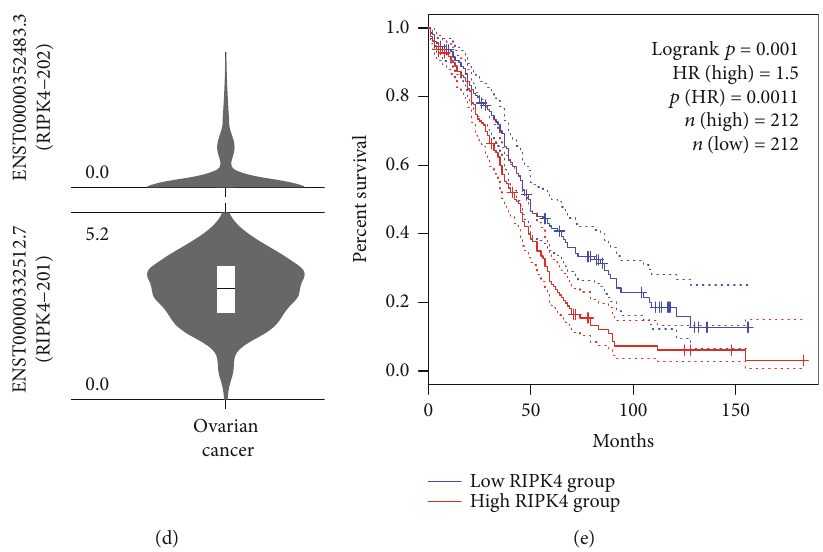
Figure 1: The expression and prognostic information of RIPK4 in OC, as analysed by GEPIA. (a) Large-scale expression pro fi ling of RIPK4 in di ff erent types of carcinoma. (b) RIPK4 mRNA expression in OC patients ( N = 426 ) was signi fi cantly higher than that in normal people ( N = 426 ) ( ∗ P < 0 : 05 ). The red column contains the OC tissues, and the black column contains the normal tissues. (c) To further identify whether RIPK4 expression is related to OC stage, GEPIA was used, which uncovered no signi fi cant di ff erence among stages II-IV. (d) Violin plots indicate that the expression level of the RIPK4-201 (ENST00000332512.7) isoform of RIPK4 is signi fi cantly higher than that of the RIPK4-202 (ENST00000352483.3) isoform in OC. (e) The Kaplan-Meier plotter demonstrates that the high levels of RIPK4 in OC are associated with a signi fi cantly worse survival rate than low levels of RIPK4 expression ( P = 0 : 0011